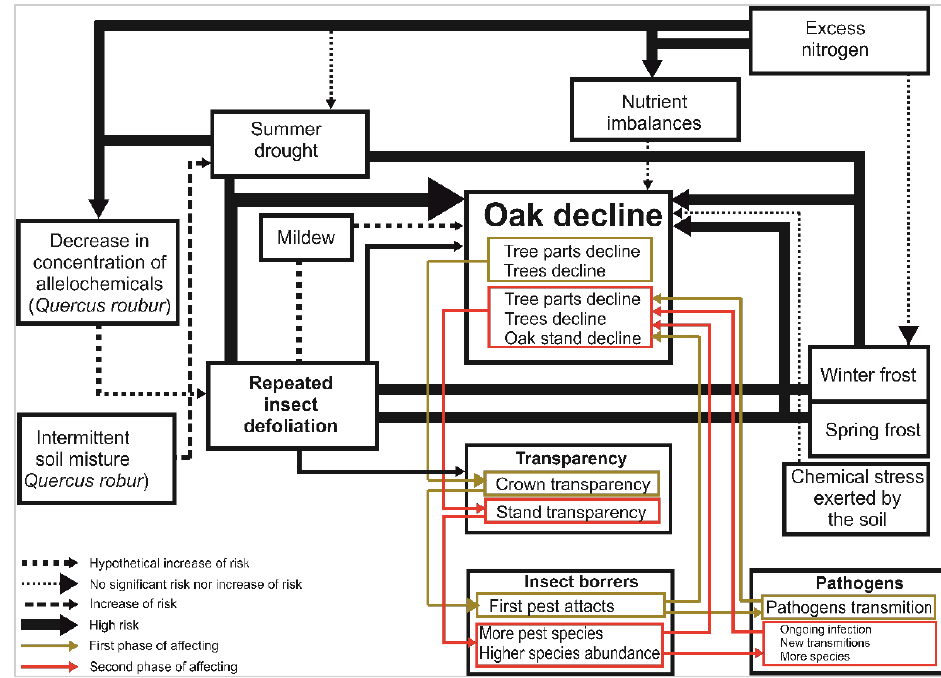
Figure 5. A conceptual model of abiotic and biotic factors involved in oak decline (modified from Thomas et al., 2002 [13]).